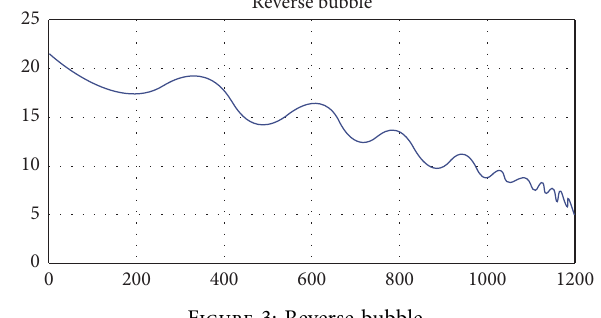
Figure 3: Reverse bubble.